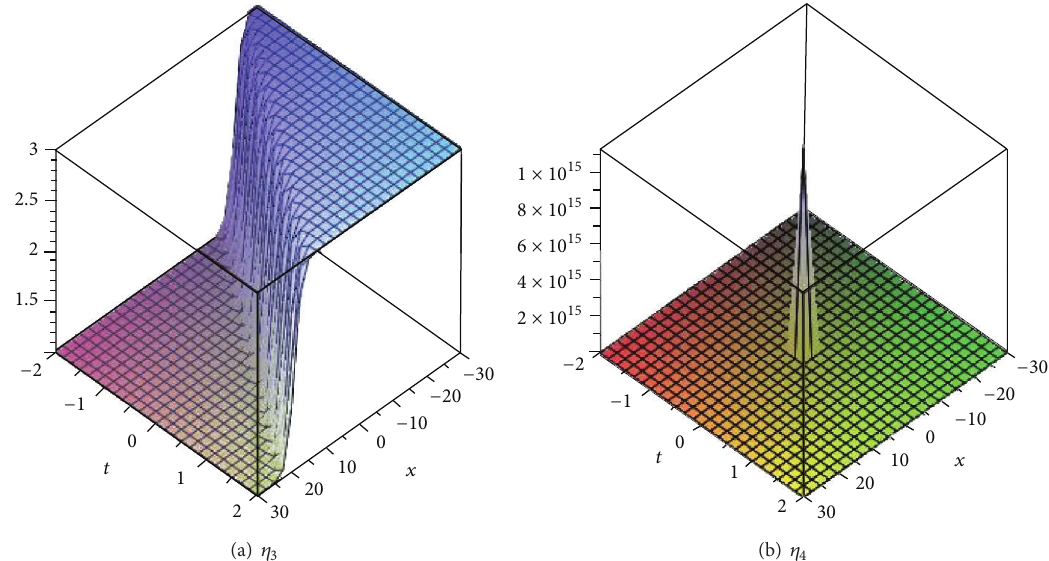
Figure 3: 3D figures of solution 𝜂 3 (𝜉) in (34) and 𝜂 4 (𝜉) in (35) with 𝑎 = −1 , 𝑏 = 1 , 𝐵 1 = −2 , 𝑁 = 12 , 𝜉 0 = 2 , 𝜃 = 1 , 𝜌 3 = 5 , and 𝛽 = 0.2 in the intervals 𝑥 ∈ [−30,30] , 𝑡 ∈ [−2,2] .